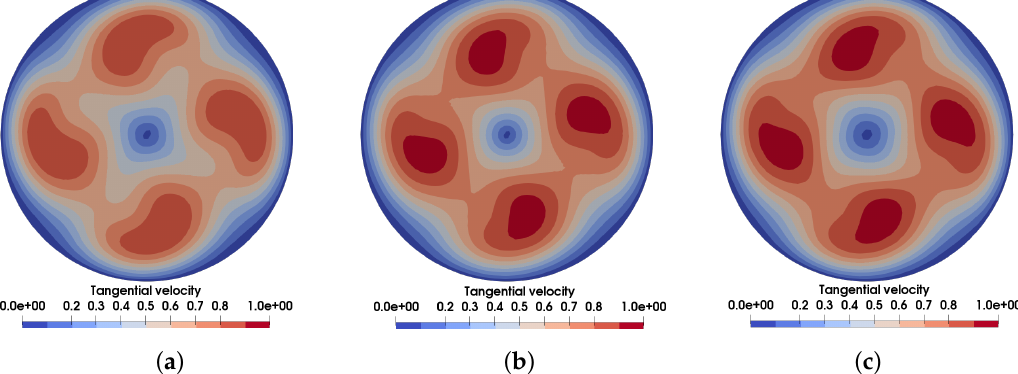
Figure 17. Tangential velocity in m/s in a cross section, 0.5 diameters downstream of the swirler exit, ( a ) Case I (left); ( b ) Case II (center) and ( c ) Case III (right).